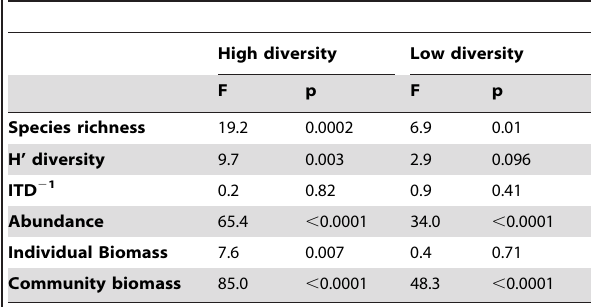
Table 6. F- and p-values of 1-way ANOVAs for each diversity group